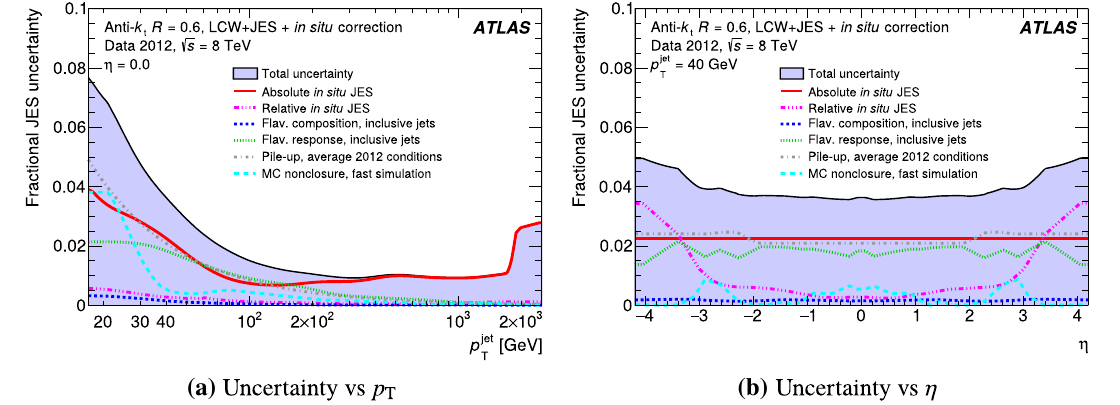
Fig. 44 Total uncertainty in the calibration of anti- k t , R = 0 . 6 jets in fast simulation as a function of p T and η . The large “MC non-closure” term demonstrates the limitations of using R = 0 . 6 jets in fast sim-